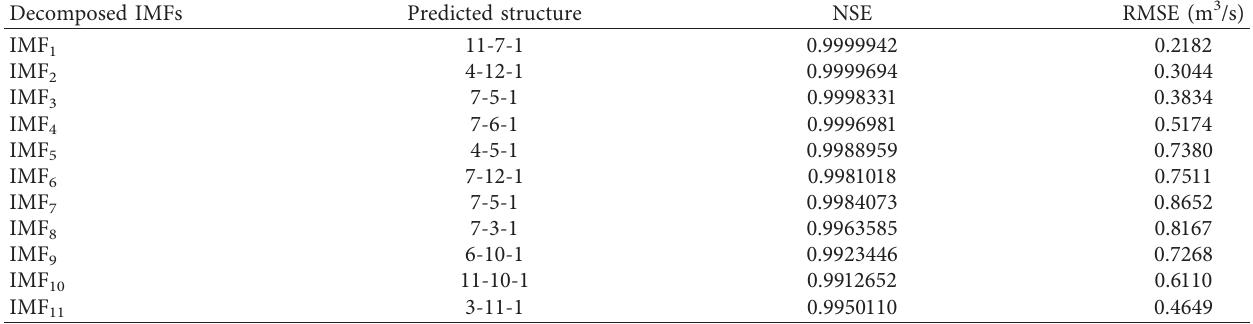
Table 7: BPNN structure of the 1st–11th IMF after VMD decomposition at the Weijiabao station.